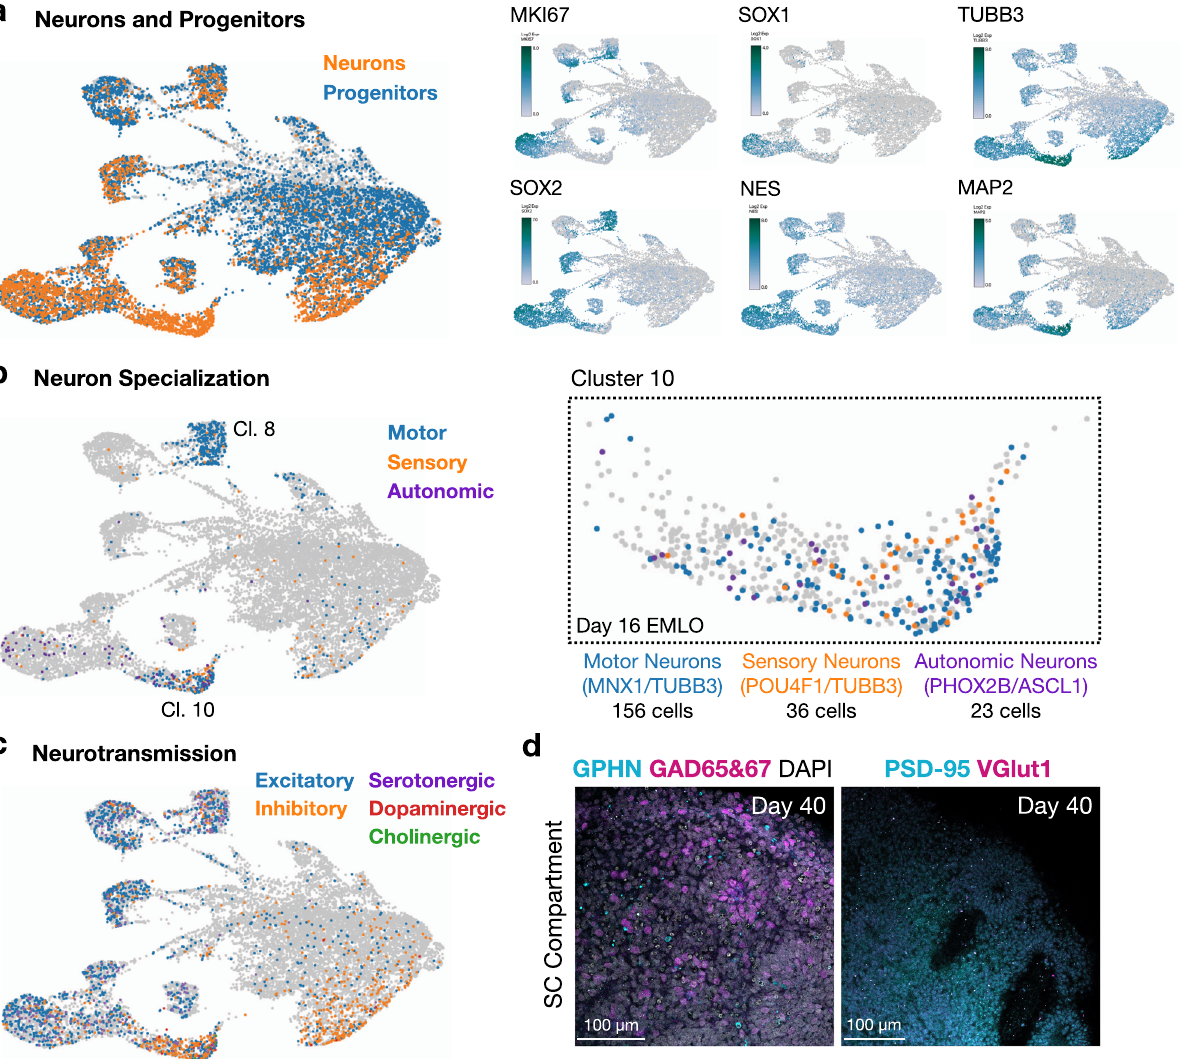
Fig. 4 Quanti fi cation of neuron specialization and neurotransmission phenotypes in EMLOs. a Distribution of neural progenitors ( TUBB3 OR MAP2 , blue) and neurons ( TUBB3 AND MAP2 , orange) in day 16 H3.3.1 EMLOs by scRNAseq (left). Canonical neuronal differentiation genes are shown (log2Exp) (right). b Proportion of specialized neurons generally classi fi ed as motor ( MNX1 / TUBB3 , blue), sensory ( POU4F1 / TUBB3 , orange), and autonomic ( PHOX2B / ASCL1 , purple) at day 16. Cluster 10 is expanded. c Proportion of neurotransmission phenotypes generally classi fi ed as excitatory (blue), inhibitory (orange), serotonergic (purple), dopaminergic (blue), and cholinergic (green) at day 16. d Inhibitory (GPHN in cyan, GAD65&67 in magenta) and excitatory (PSD-95 in cyan, VGlut1 in magenta) neurotransmission biomarkers in SC at day 40 ( N = 2 repeat experiments). Individual scale bars